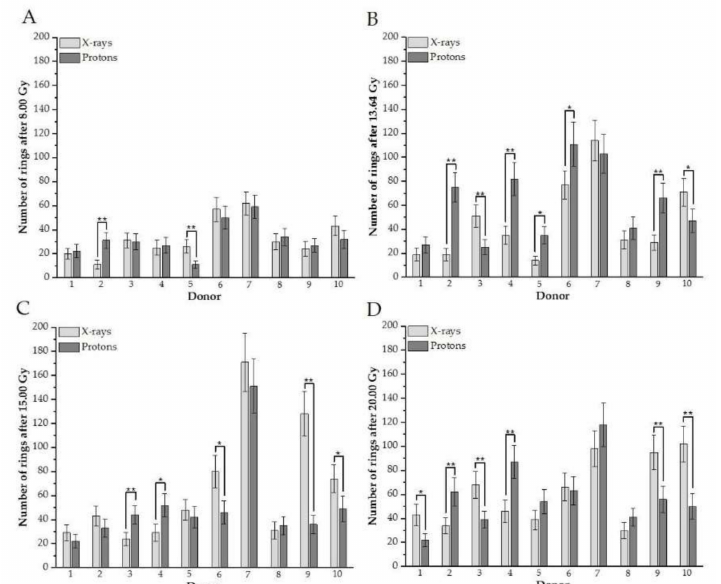
Figure 3. ( A – D ). An individual number of rings between donors in G2/M cells irradiated with different doses of protons vs. X-rays ( A : after 8 Gy, B : 13.64, C : 15.00 Gy, D : 20.0 Gy). Each column represents scored rings with error bars as a standard deviation. *, p < 0.05; **, p < 0.001. Donor #1, #2, #7, #9, and #10 are female; #3, #4, #5, #6, and #8 are male